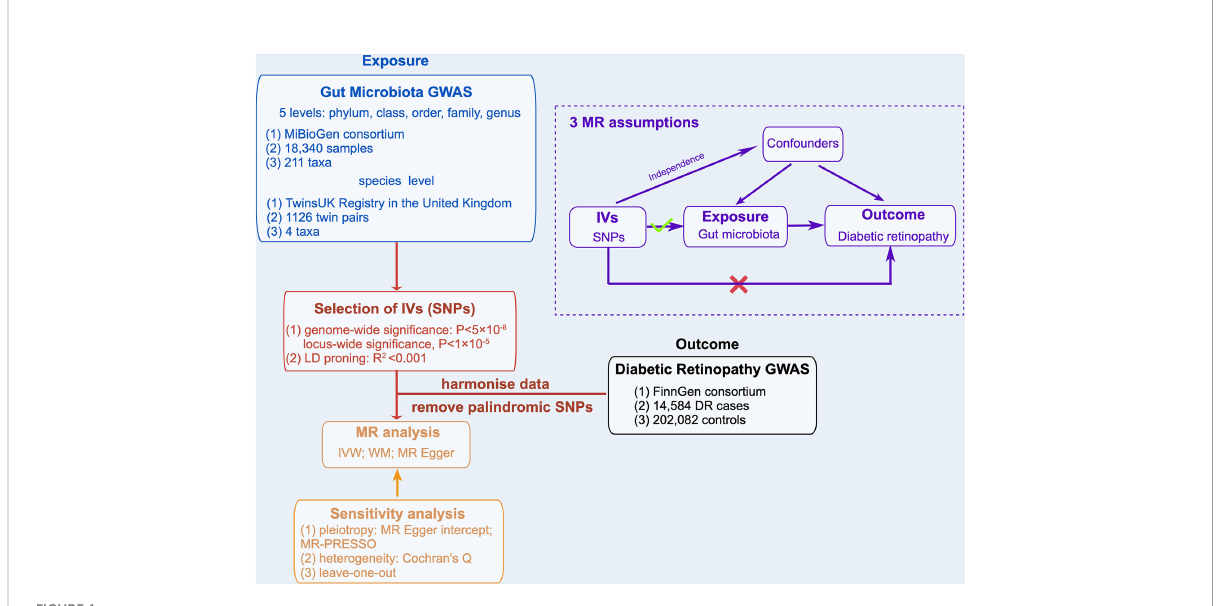
FIGURE 1 Overview of MR analyses process and major